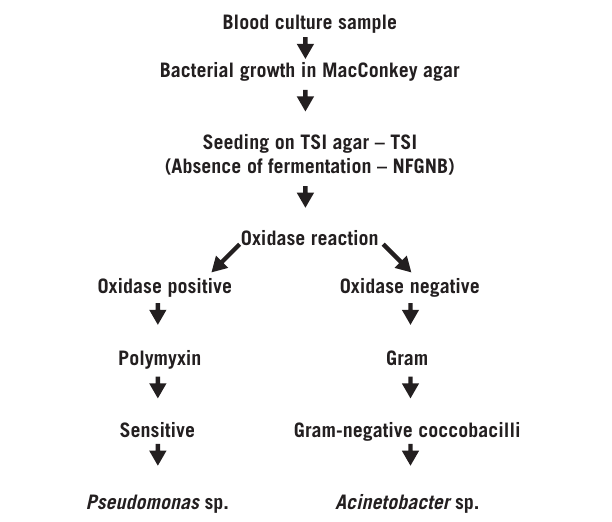
figurE 1 − Simplified flowchart of isolation and identification of the main NFGNB in hospital blood